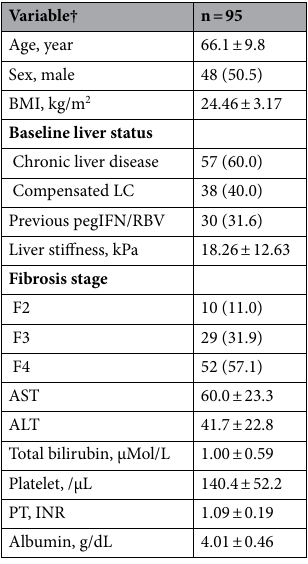
Table 1. Baseline characteristics of patients. † Continuous variables are described as mean ± standard deviation. Nominal variables are described as number (percentage). BMI, body mass index; LC, liver cirrhosis; IFN, interferon; AST, aspartate transaminase; ALT, alanine transaminase; PT, prothrombin time; INR, internationalized ratio; SVR, sustained viral response.